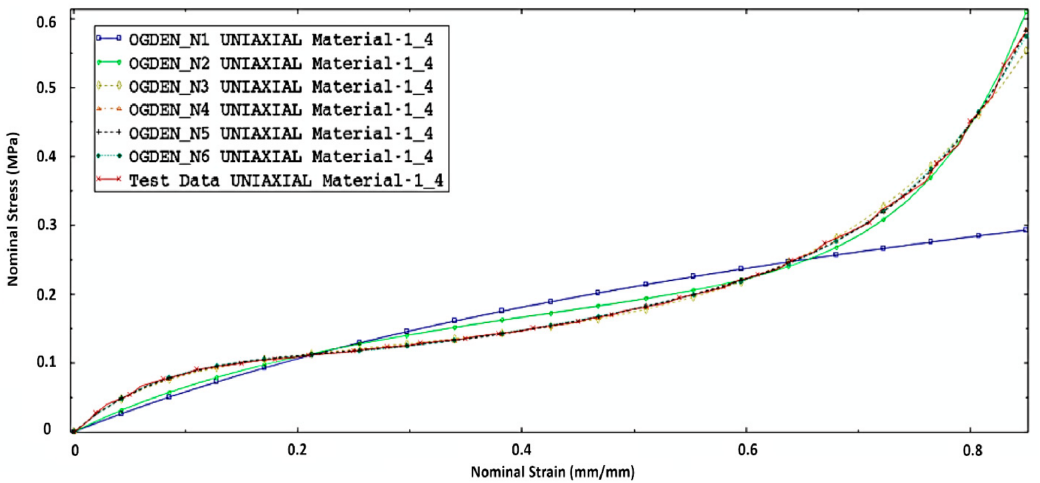
Figure 15. The simulations nominal stress-nominal strain curves of the Ogden model and experimental test data at a quasistatic loading rate of 2